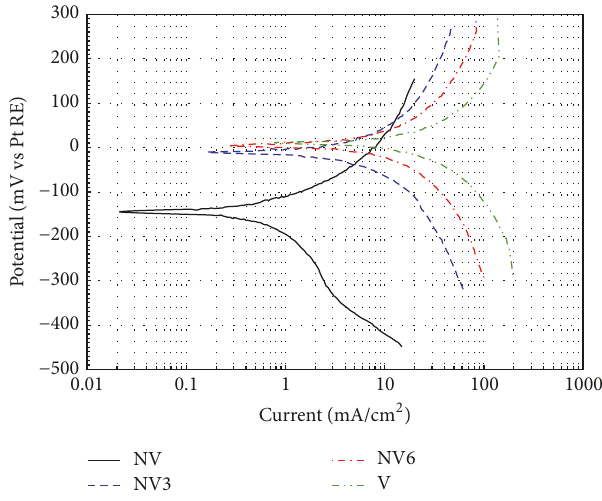
Figure 3: Potentiodynamic polarization curves for Ni NV, NV3, NV6, and V at 900 ∘